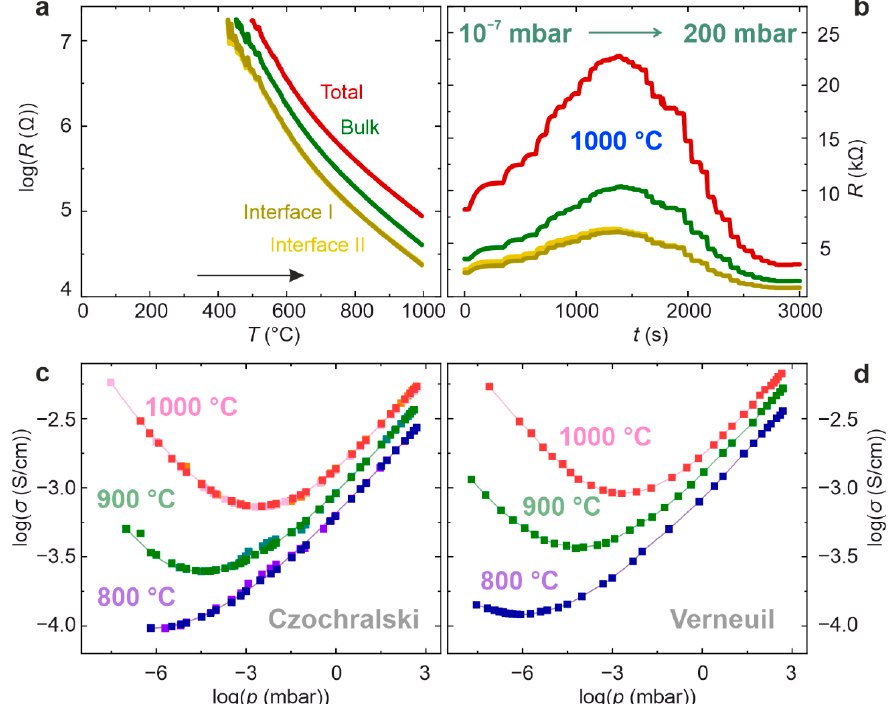
Figure 3. ( a ) Resistance during reannealing to 1000 ◦ C under vacuum conditions following previous oxidation; ( b ) step-wise exposure to oxygen at 1000 ◦ C; ( c ) Brouwer diagram of the macroscopic conductivity measured at different temperatures by step-wise oxidation (the differently toned data points indicate repeated measurement runs); and ( d ) Brower diagram measured on Verneuil grown SrTiO 3 for comparison